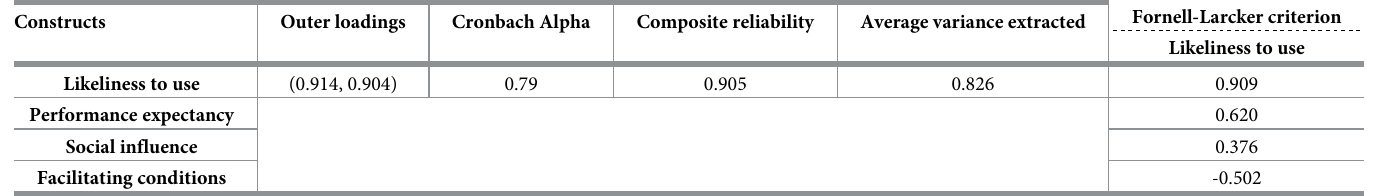
Table 3. Internal consistency reliability, convergent validity and discriminant validity of the reflective construct variable, likeliness to use.